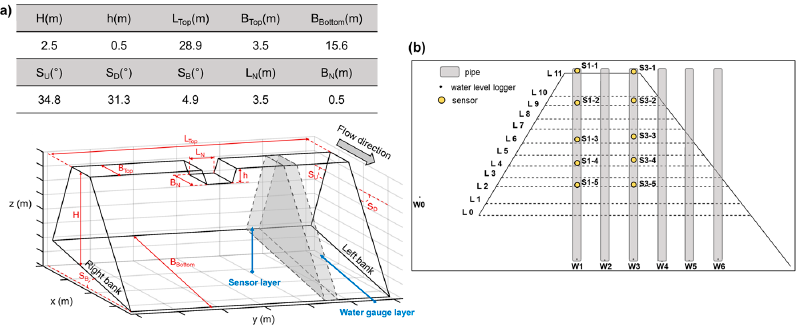
Figure 10. Seepage test of the earth dam: ( a ) dimensions of the earth dam and ( b ) location of sensors and water level loggers.